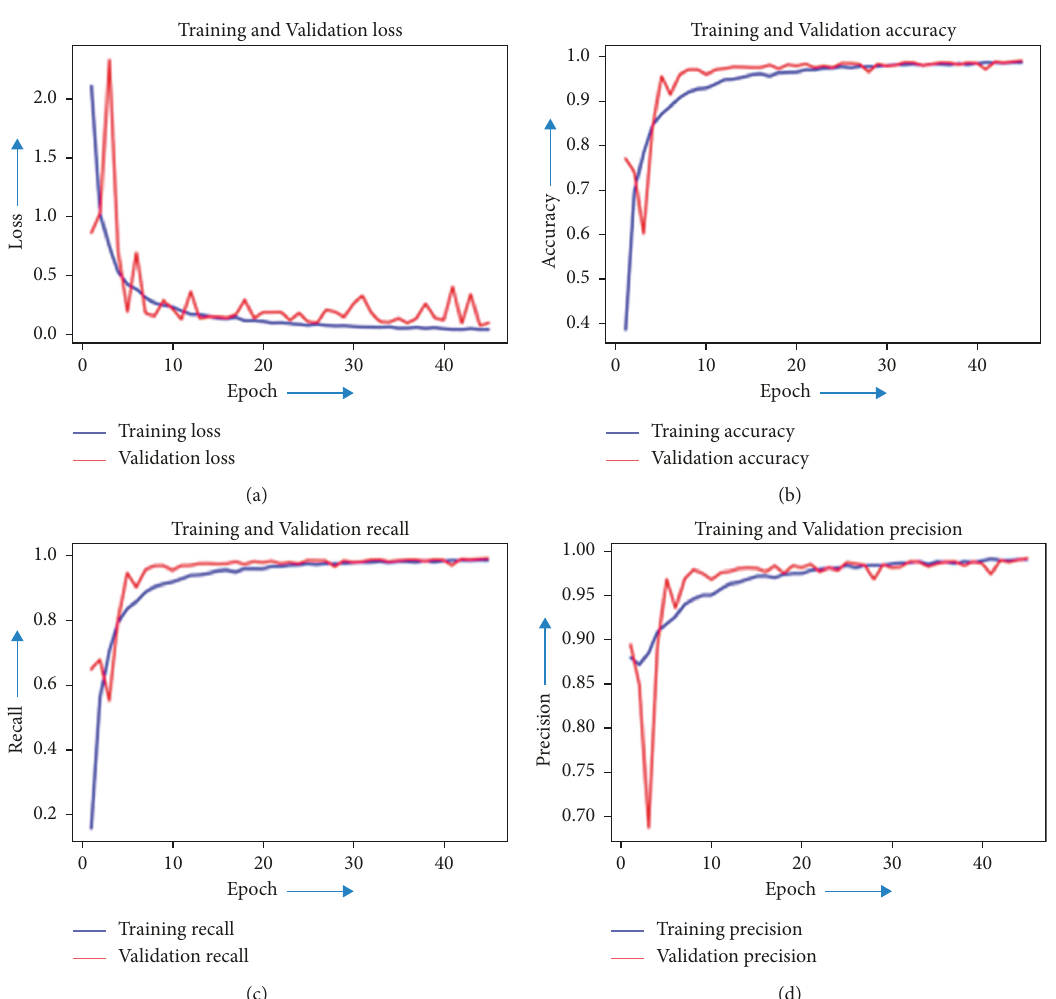
Figure 5: Plot curve obtained for the training and validation dataset using ADAM optimizer with a LR of 0.001 and 45 Epochs, (a) loss, (b) accuracy, (c) recall, and (d)